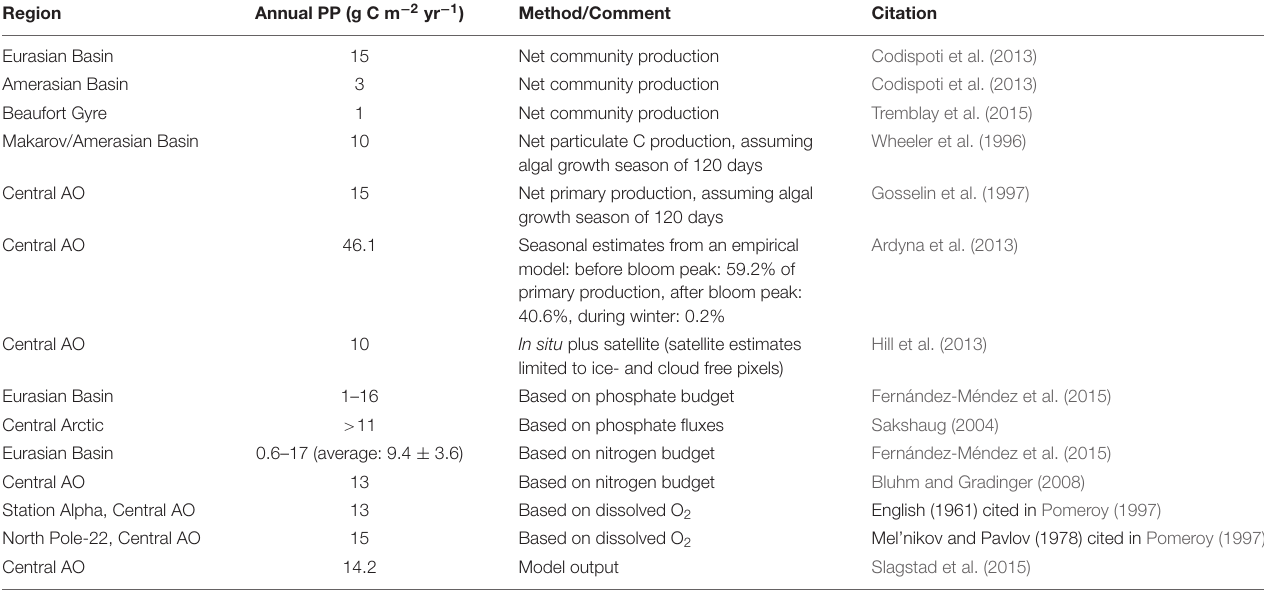
TABLE 2 | Annual primary production estimates in the Arctic Ocean (AO) basins.